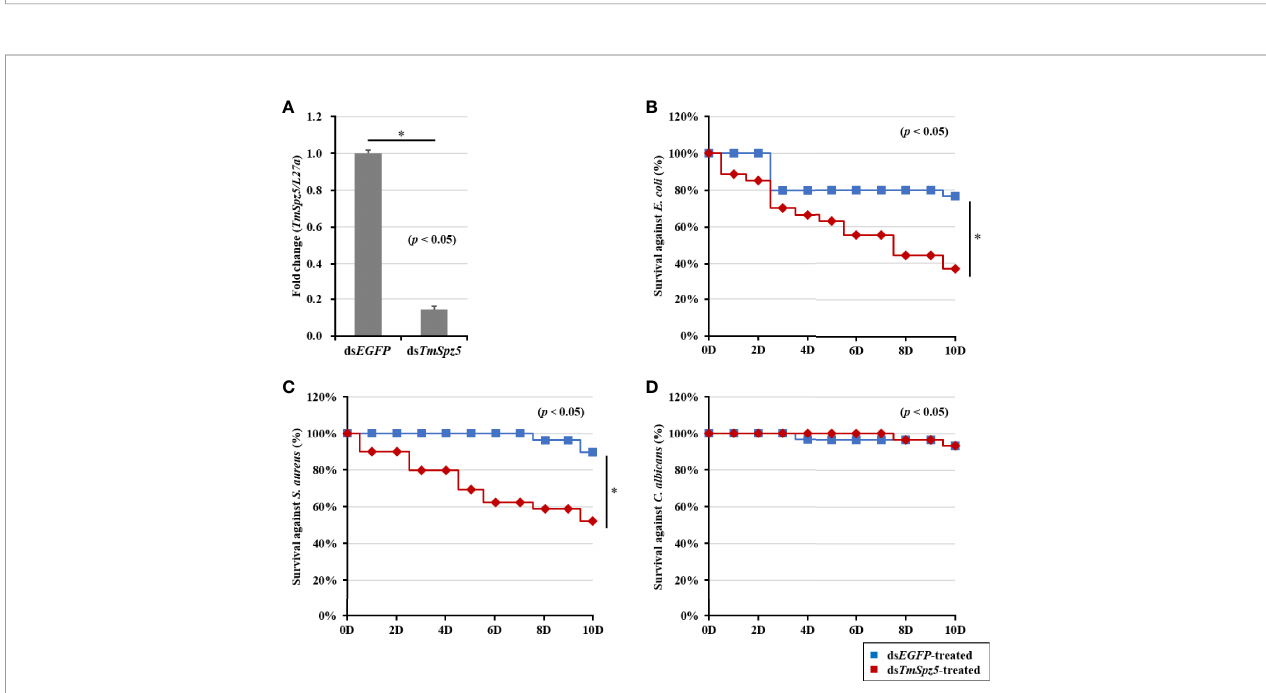
FIGURE 5 | Effect of TmSpz5 gene silencing on the survival of T. molitor larvae. The silencing ef fi ciency of ds TmSpz5 was measured by qRT-PCR at 4 days postinjection (A) . TmSpz5 -silenced larvae were injected with E . coli (B) , S. aureus (C) , and C . albicans (D) , and survival rates were studied over 10 days post- pathogen injection (n = 10 per group). Larval survival rates at 10 days post-microbial injection were 33% after E. coli injection, 58% after S. aureus injection, and 90% after C . albicans injection compared with the levels in the ds EGFP- injected control group. The data are reported as averages of three biologically independent replicates. Asterisks indicate signi fi cant differences between ds TmSpz5 - and ds EGFP -injected groups. The survival analysis was performed using Kaplan – Meier plots (log-rank chi-squared test; * p <